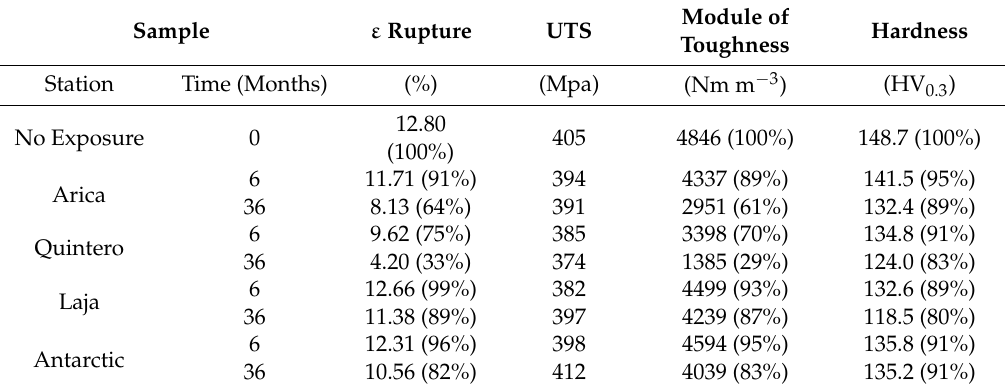
Table 5. Specified mechanical properties of tensile and hardness testing of SAE 1020 steel samples exposed to different environments at selected exposure